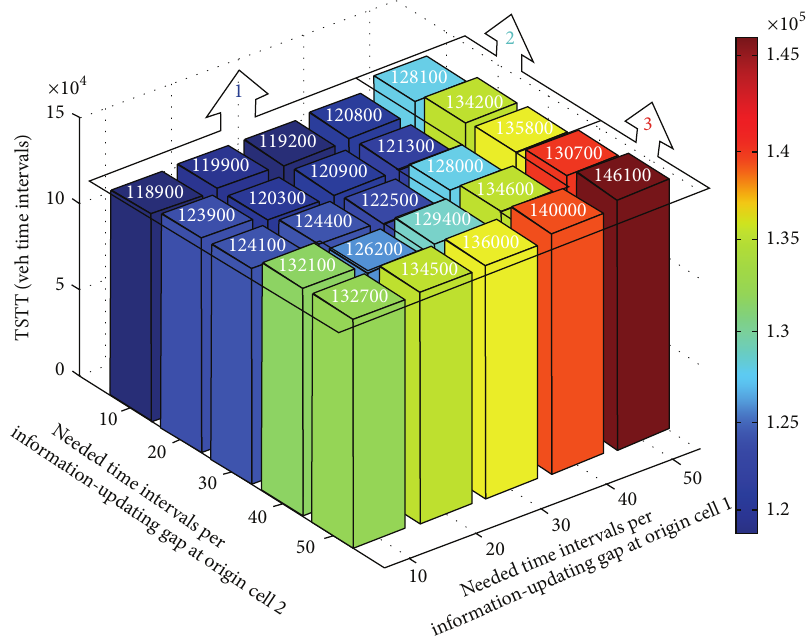
Figure 5: Relation of information-updating frequency and TSTT.